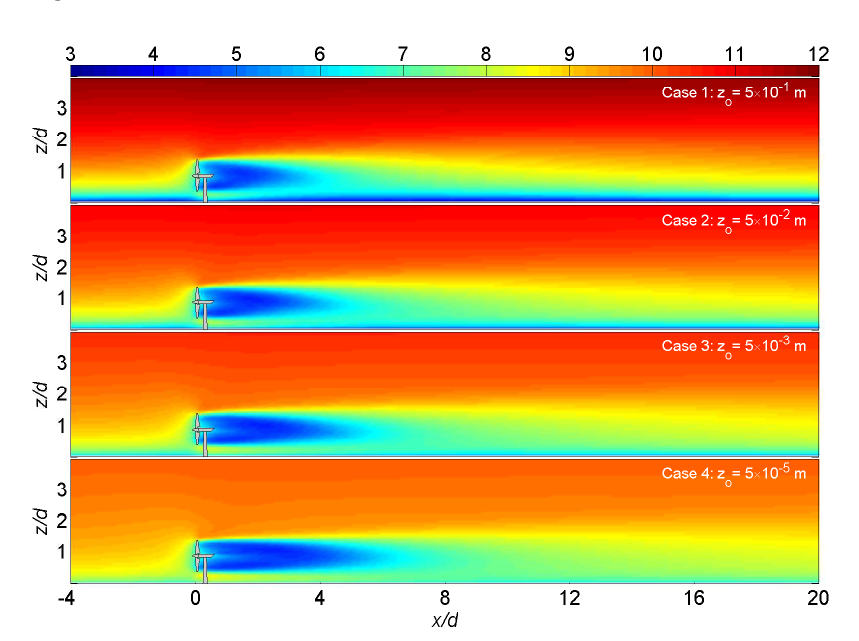
Figure 3. Contours of the time-averaged streamwise velocity u (m s − 1 ) in the middle vertical plane perpendicular to the turbines installed over flat surfaces with different roughness lengths.